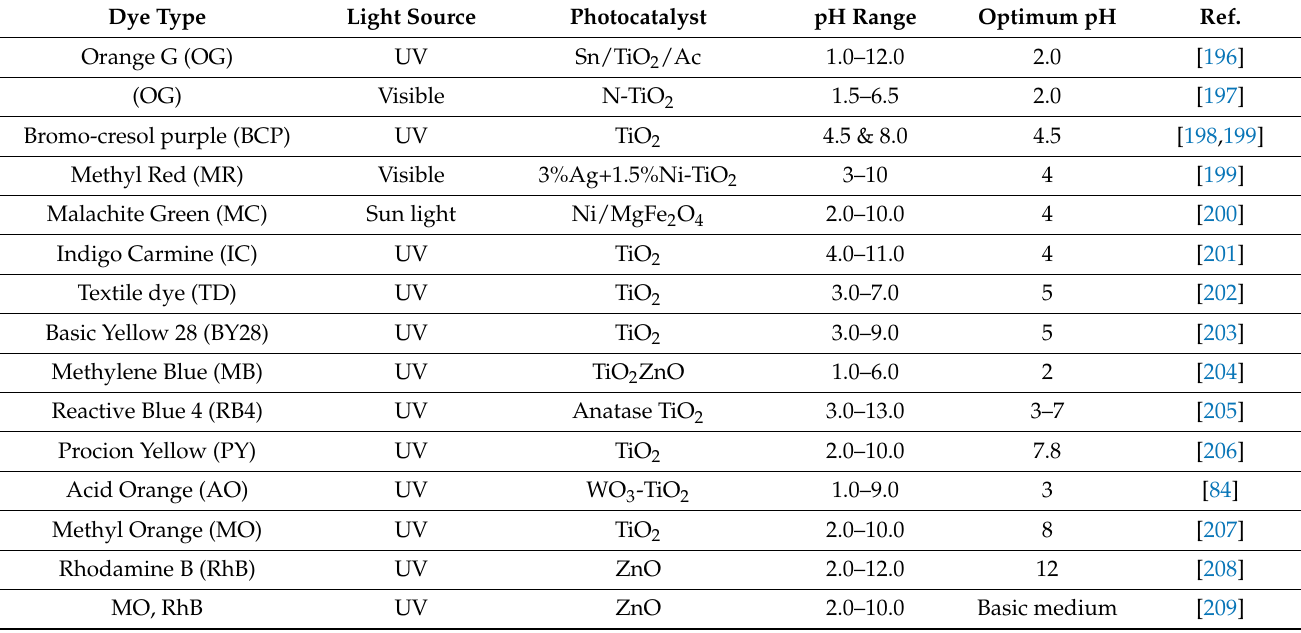
Table 11. Different types of dyes under optimum